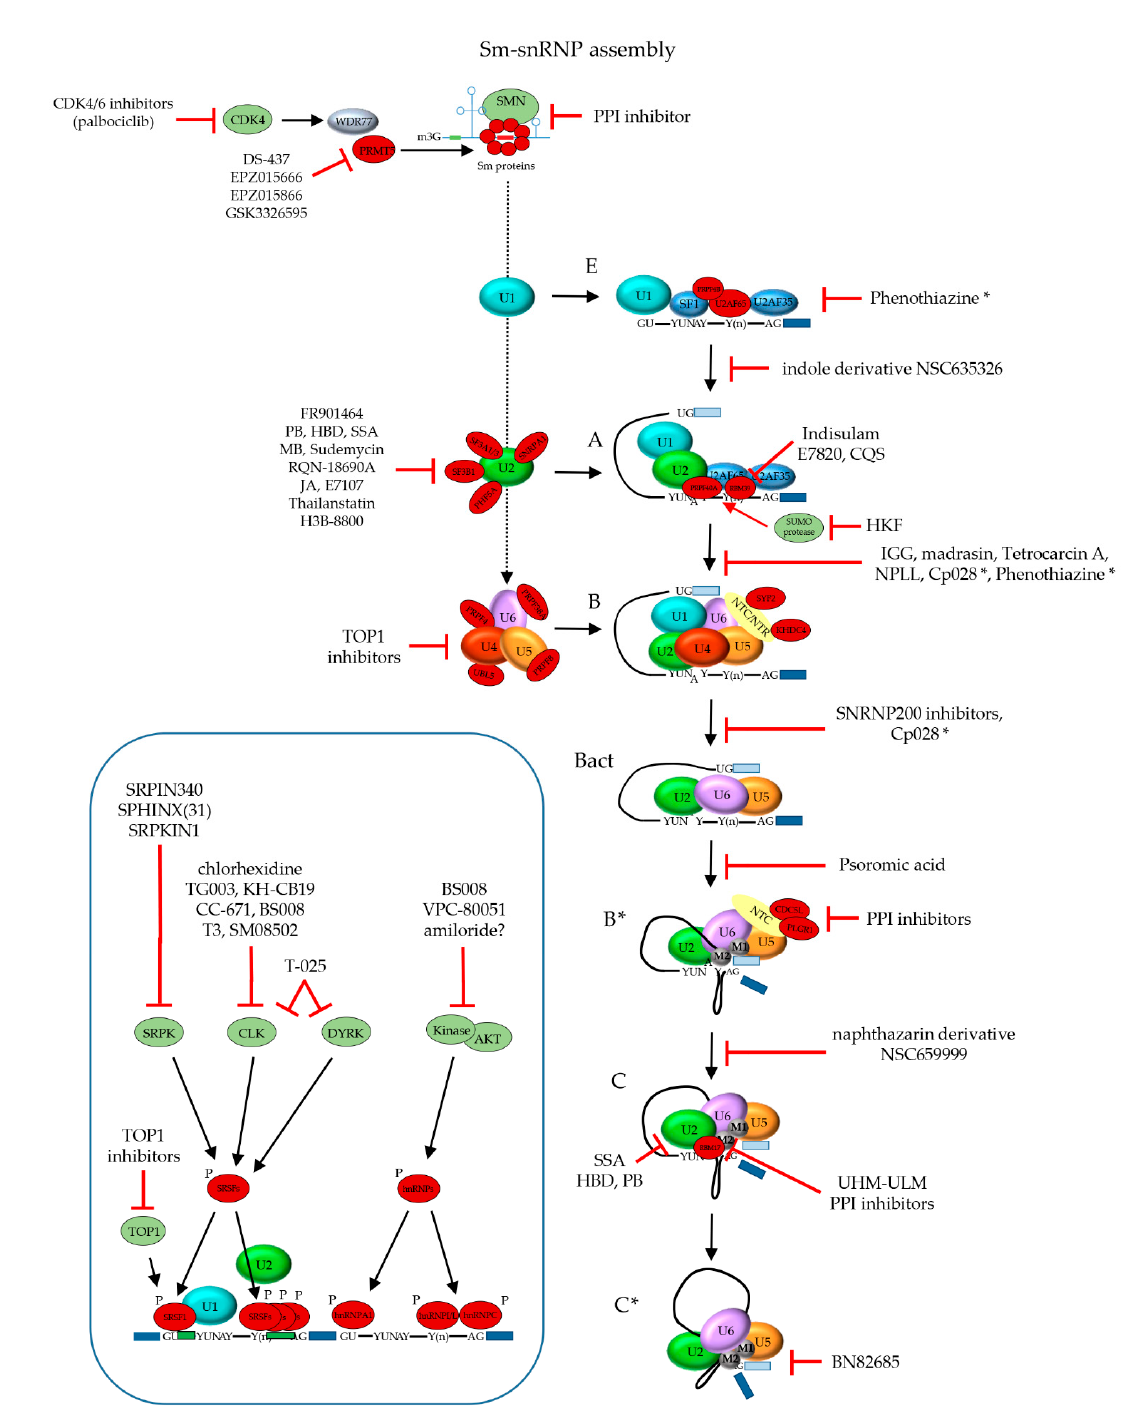
Figure 7. Therapeutic targets in the spliceosome and inhibitors of the mRNA splicing reaction. Main figure: structural components of the spliceosome needed for the mRNA splicing reaction; insert: splicing factors that regulate splice site usage. Identified targets in the spliceosome are shown in red. Main representative molecules and classes of splicing inhibitors are shown, with an indication of their interference with the process. For several inhibitors, the target protein is known; for others only the spliceosome complex that is inhibited, or the complex transition step that is prevented. In cases where there is doubt about the step that is inhibited, the compound is shown at multiple steps and marked with an asterisk.